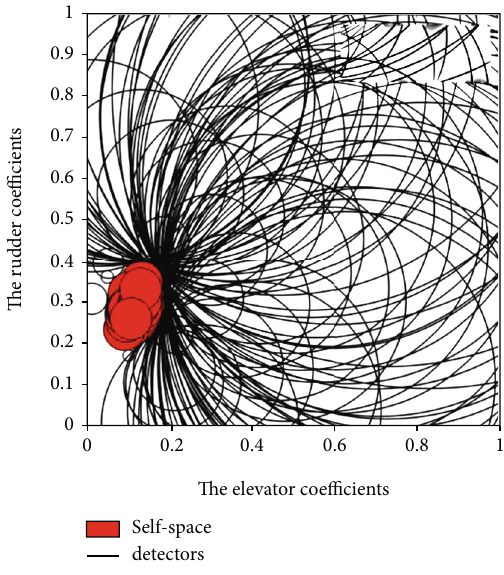
Figure 11: Detectors generation of